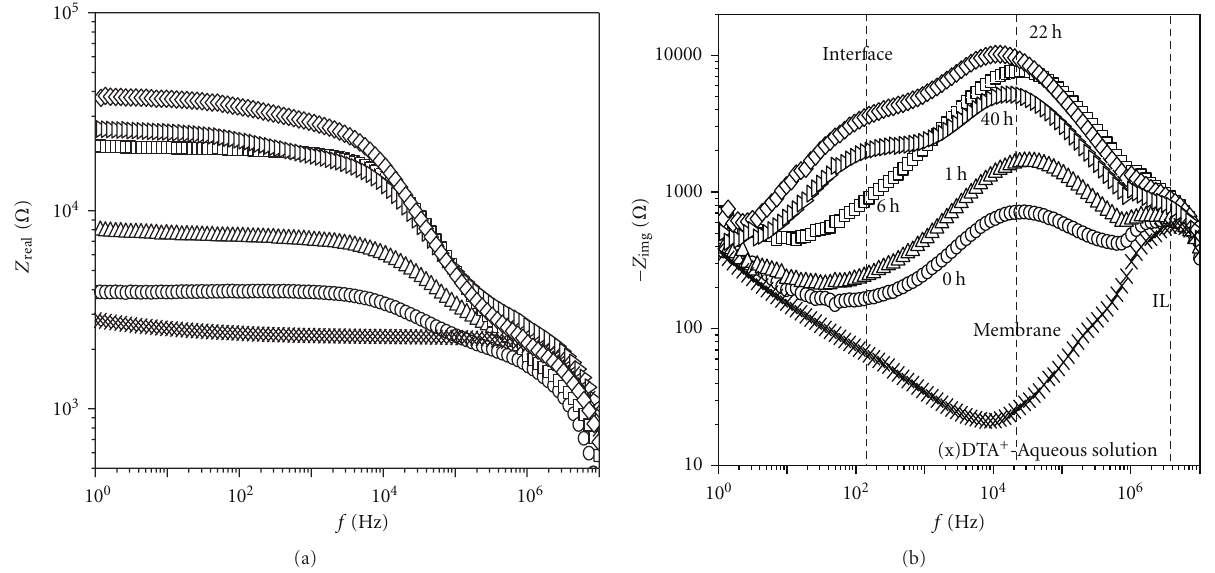
Figure 9: (a) Variation of the (a) real part of the impedance versus frequency and (b) imaginary part of the impedance versus frequency as a function of the Nafion-112 membrane contact time with the IL-solution. (o) t = 0, ( (cid:7) ) t = 1h, ( (cid:5) ) t = 6h, ( ♦ ) t = 22 h, and ( ∇ ) t = 40 h. Impedance results for the IL-solution alone ( × ), this means without any membrane in the measuring cell are also